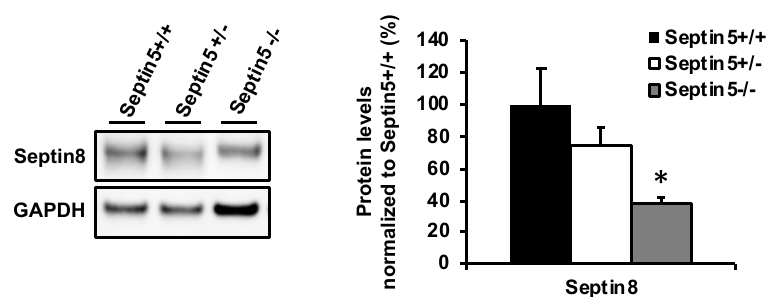
Figure A2. Septin8 protein levels show a dose-dependent decrease in the temporal cortex of the Septin5 +/ − and Septin5 − / − mice as compared with the Septin5 +/+ mice. Protein levels were normalized to GAPDH and are shown as a % of Septin5 +/+ , mean ± SEM. Septin5 +/+ ( n = 5), Septin5 +/ − ( n = 5), Septin5 − / − ( n = 4). - one-way ANOVA, post hoc LSD. * p < 0.05.